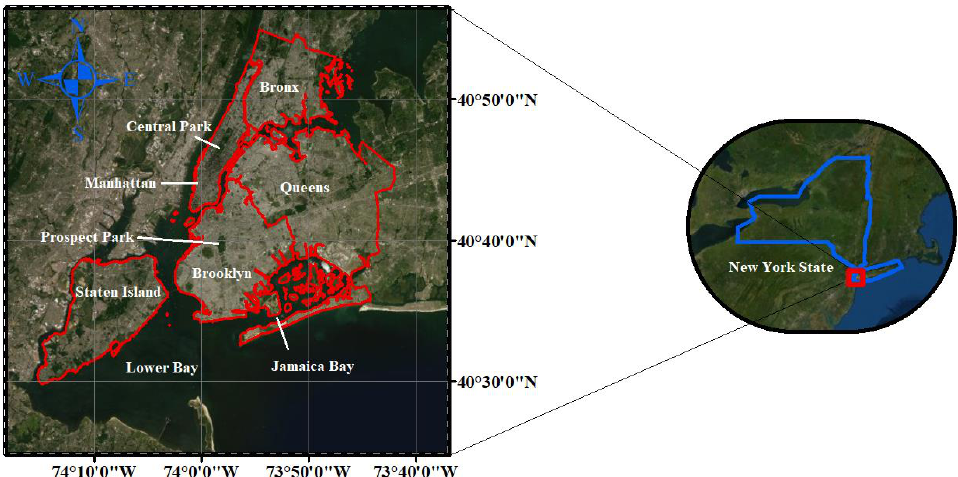
Figure 1. Location of the study area—New York City (data source is the NYC Open Data at https://opendata.cityofnewyork.us/ (accessed on 10 September 2021)). A heat island effect exists in NYC, with the mean temperatures at Central Park generally being 1.20 – 3.02°C lower than the surrounding temperatures, and the surface air temperature of the city is up to 8°C warmer than the rural areas within 100 km of the city and the difference becomes more pronounced during heat wave conditions [34,35]. For instance, the urban heat island intensity was observed to be nearly twice in July 2016 over NYC compared to the decadal mean [35].